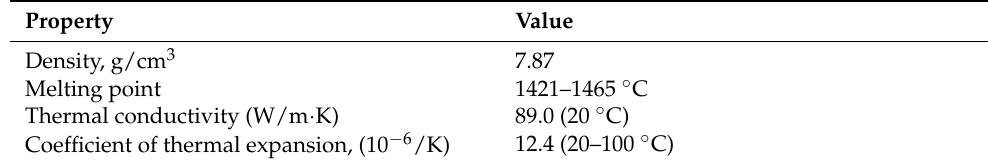
Table A3. Physical Properties Hot rolled Low Carbon Steel (AISI